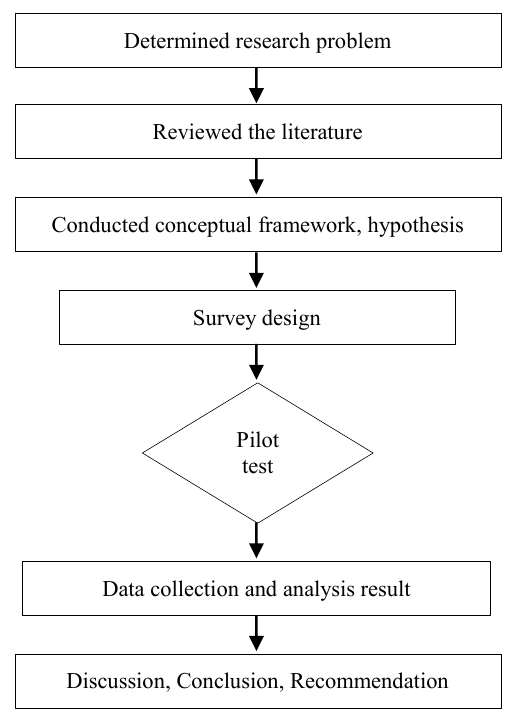
Figure 1. Flow chart of research